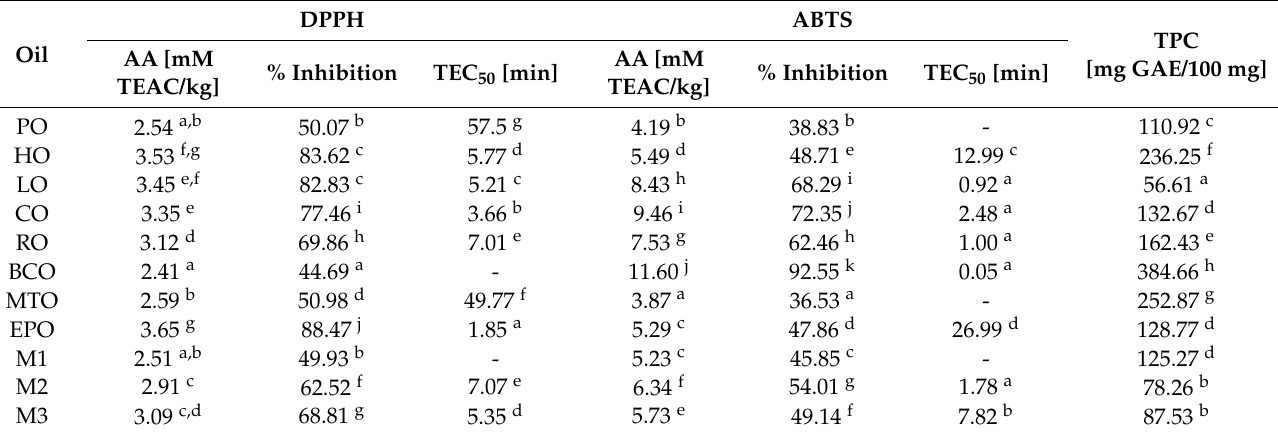
Table 3. Antioxidant activity of analysed